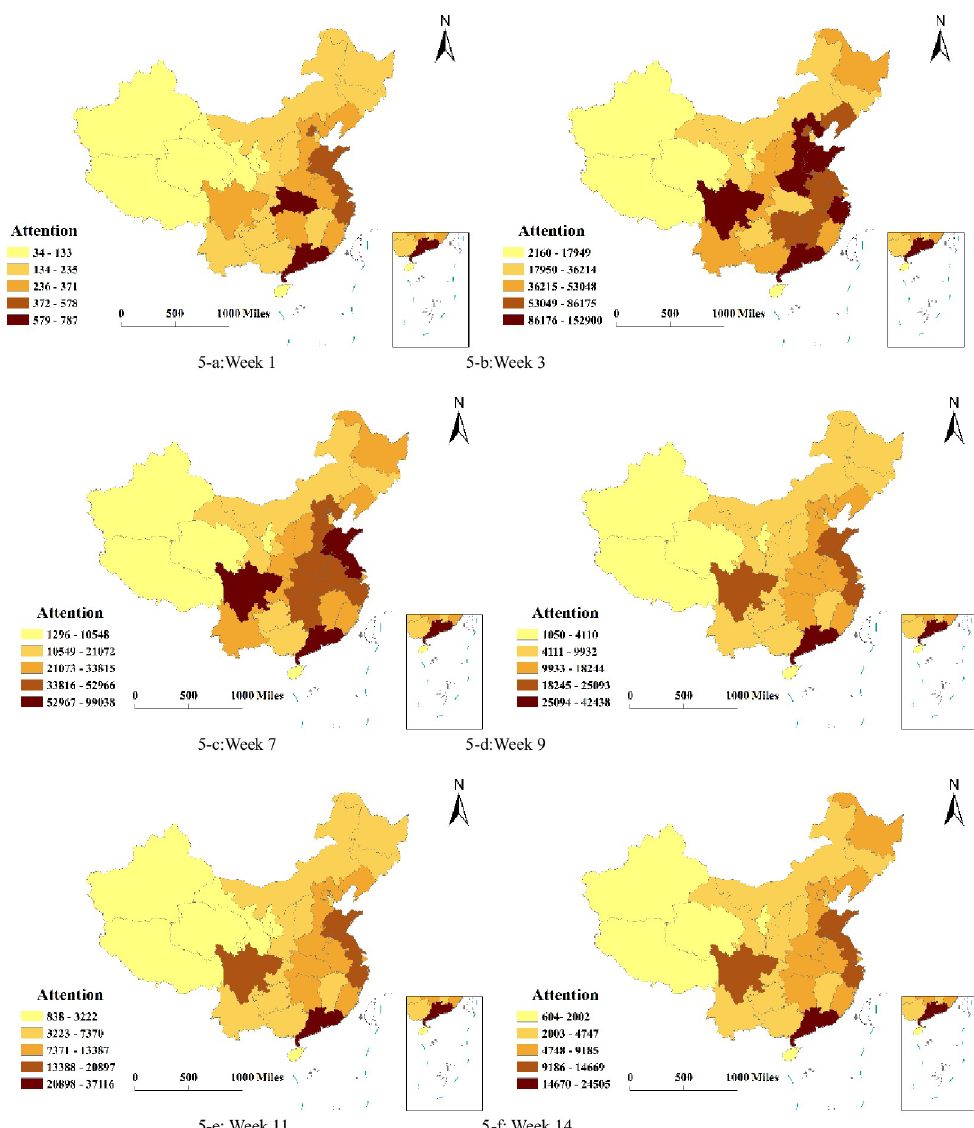
Fig 5. Spatial distribution characteristics of network attention. Source: The primitive base map from the website of the Ministry of Natural Resources of China (http://bzdt.ch.mnr.gov.cn/) was plotted by ArcGIS 10.2 software (ESRI 1 ), and its Drawing Review Number is GS (2016)